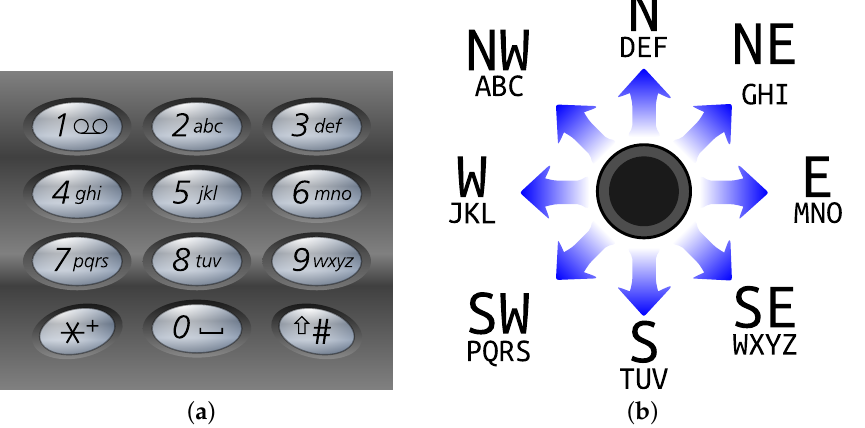
Figure 9. Hiding data with a joystick: ( a ) Keypad of an old telephone; ( b ) Mapping from joystick positions to